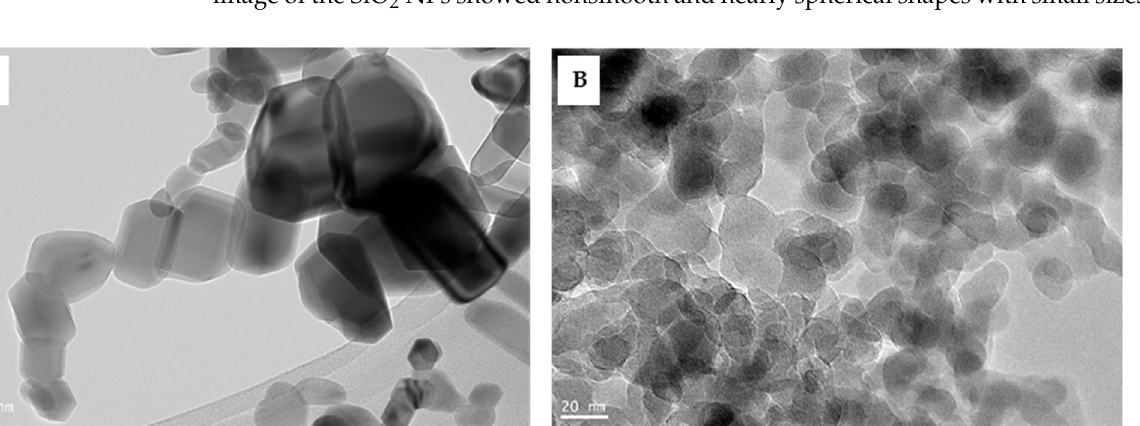
Figure 2. TEM images of ZnO NPs ( A ) and SiO 2 NPs ( B )